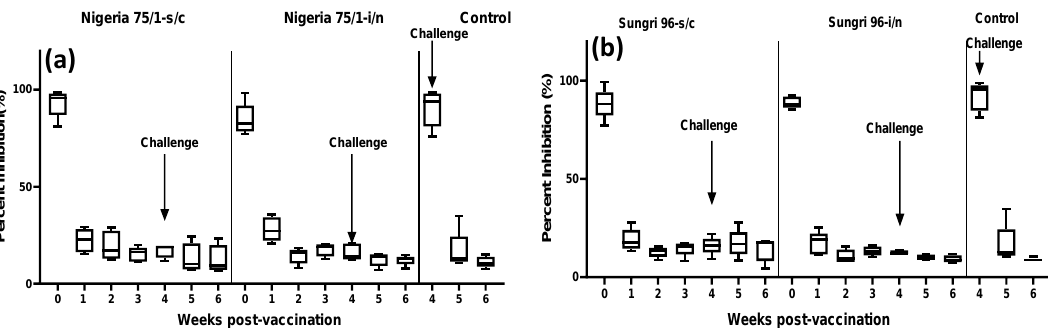
Figure 3. Anti-N antibody response following vaccination and challenge as measured by N-protein based cELISA. The results are presented as percent inhibition values. The data are presented as box-and-whisker plots, in which the bars span the minimum and maximum values of five animals, and the box shows the range from the first to the third quartile. The central horizontal line in each box shows the median value. Day of challenge is shown by an arrow in each graph. ( a ): Percent inhibition values in Nigeria 75 / 1 vaccine study; ( b ) percent inhibition values in Sungri 96 vaccine study.